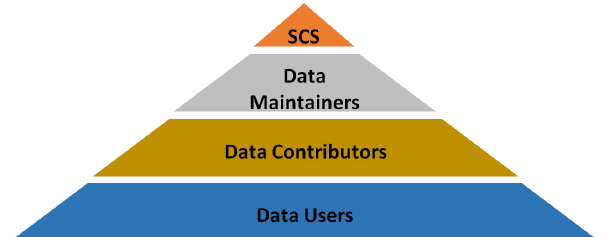
Figure 7. A simplified depiction of the TropSOC governance. The scientific steering committee (SCS) is responsible for approving major management decisions. The TropSOC core team as data maintainers are responsible for implementing broader changes to- gether with new data contributors. All interested scientists are wel- come to contribute data to future versions of the database or access the data for their own